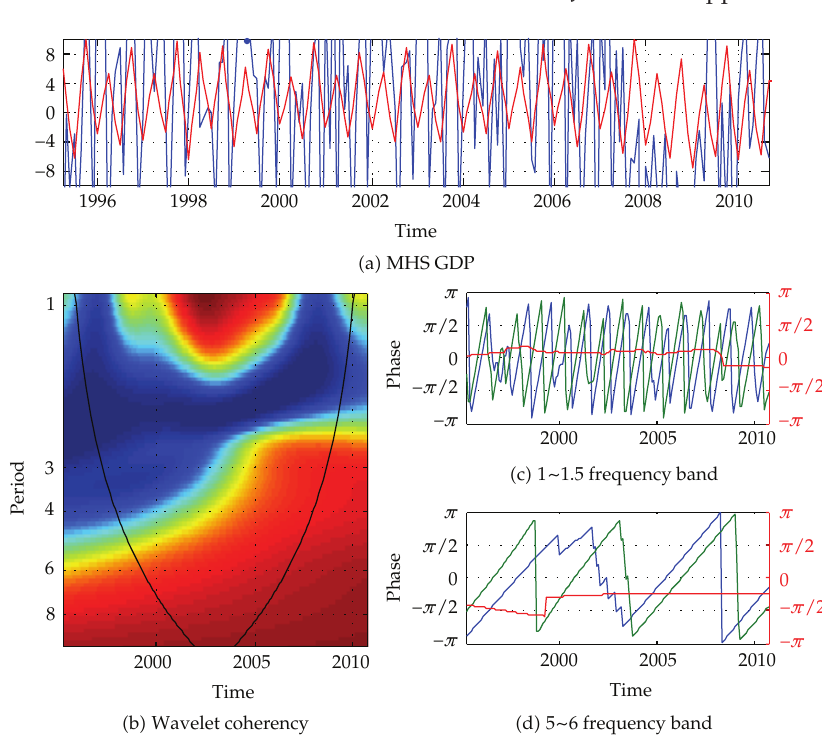
Figure 15: Wavelet coherency between MHS and